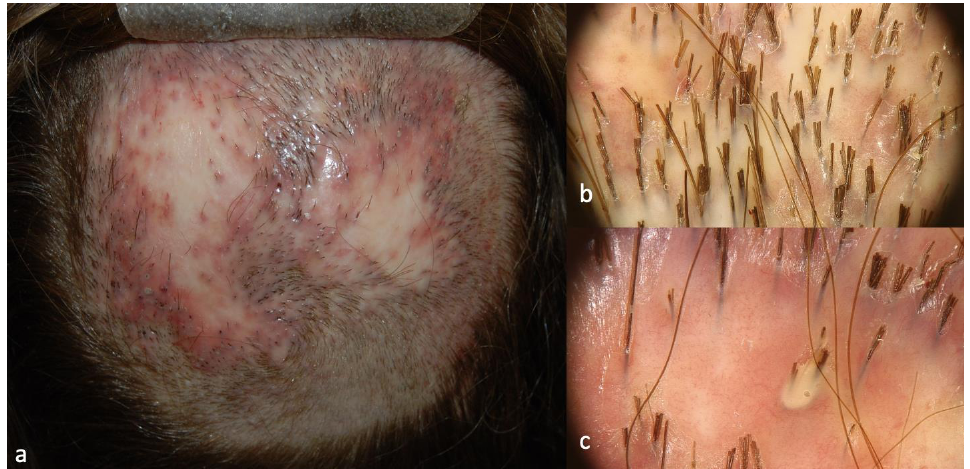
Figure 3. Clinical ( a ) and trichoscopic findings of Patient 2 and ( b , c ) magnification 20×.